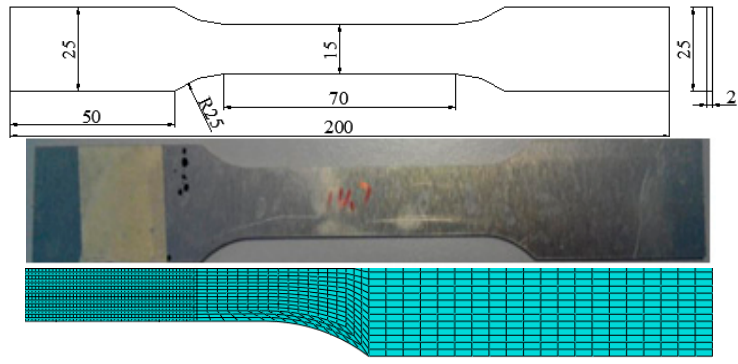
Figure 1. The specimens for the uniaxial tensile test.